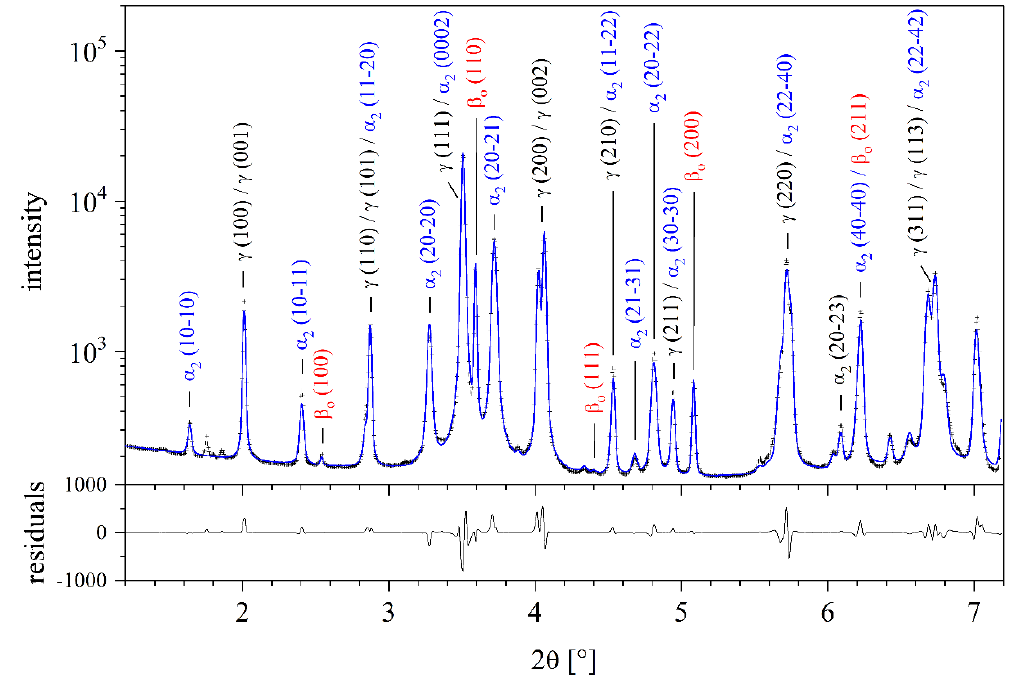
Figure 2. Diffraction pattern of the investigated TNM alloy at RT, measured using X-rays with an energy of 87.1 keV (wavelength 0.1423 Å). The blue line is a fit to the data, calculated with Maud.